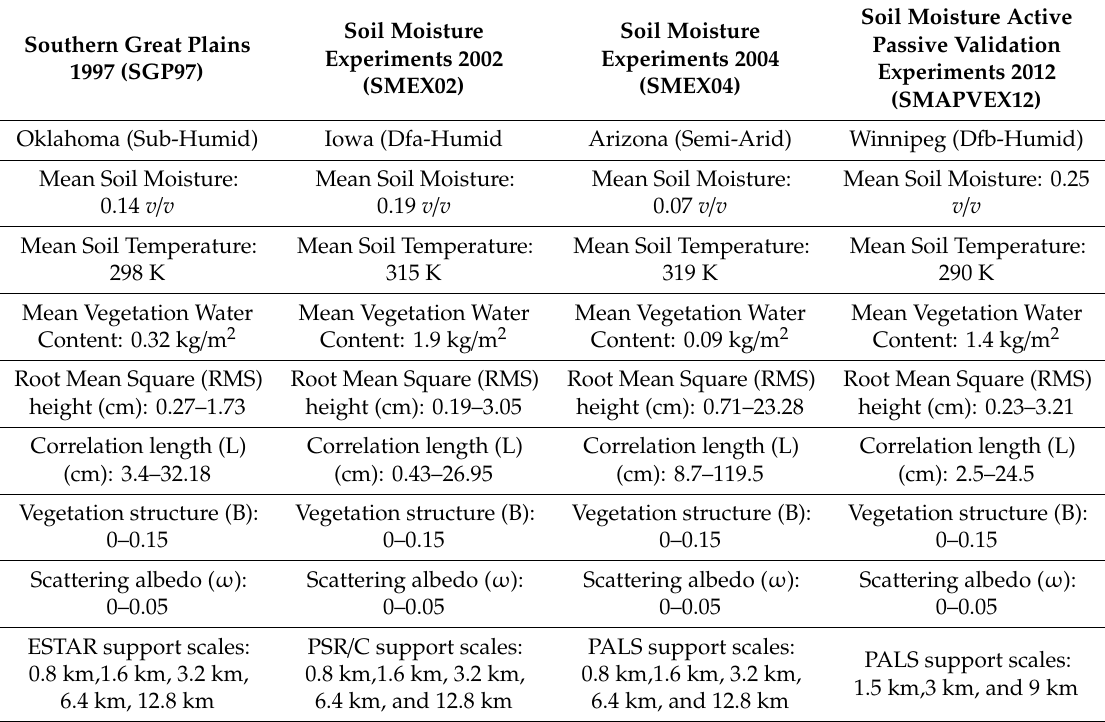
Table 1. The mean values of land surface variables used in the analysis for various field